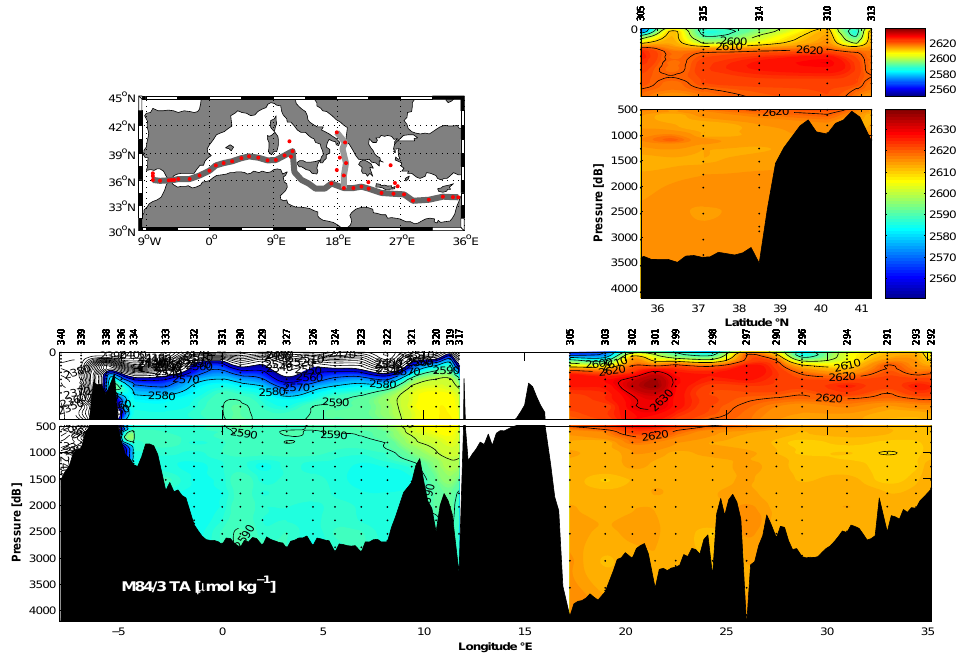
Fig. 5. Sections of TA (µmolkg − 1 ) in the Mediterranean Sea from the Meteor cruise M84/3 in April of 2011. The top right panel is a meriodional section from the Adriatic Sea to the Ionian Sea (light gray line on the map) and the lower panel is the zonal section from the coast of Lebanon in the Eastern Mediterranean Sea to through the Strait of Gibraltar (dark gray line on the map). The depth scale and the colour scale are identical all both panels. The top 500dbars in each section are slightly expanded. No stations are shown in the Atlantic due to the very different TA encountered there as compared to the Mediterranean Sea.